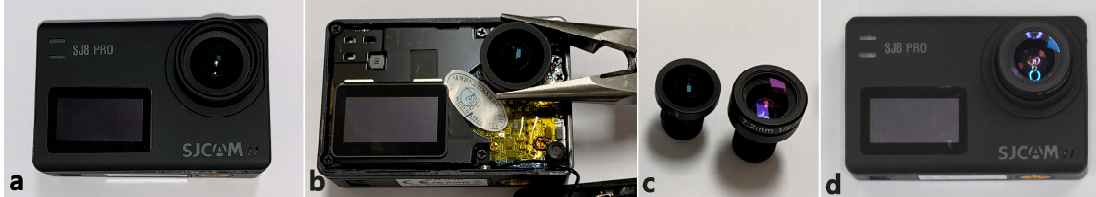
Figure 2. Modified action camera with 7.2 mm lens. ( a ) SJCAM Pro Action Camera (SJCAM, Shenzhen, China), ( b ) Removing the front lid of action camera and 2.8mm stock lens, ( c ) 2.8mm stock lens and 7.2mm telephoto lens, ( d ) modified action camera with 7.2mm telephoto lens.